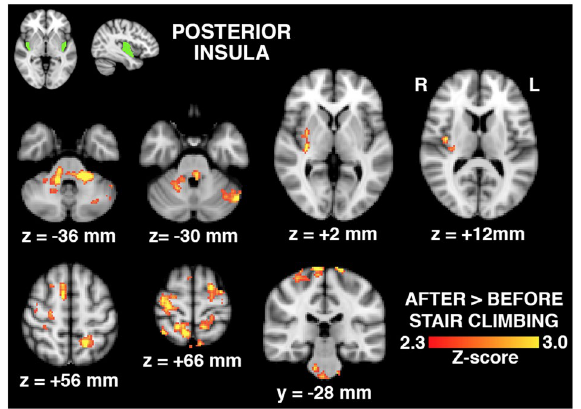
Figure 6. Brain regions (bottom, in red-to-yellow) exhibiting increased connectivity with the posterior insula seed region (top, in green) in hip OA patients (n = 30) following physical activity involving the hip, expressed as a statistical Z-score of the difference. Regions include the brainstem, bilateral cerebellum, right putamen and posterior insula, and regions of the motor and sensory cortices, including those associated with hip movement and sensation (y,z-coordinates of shown brain slices correspond to the MNI brain